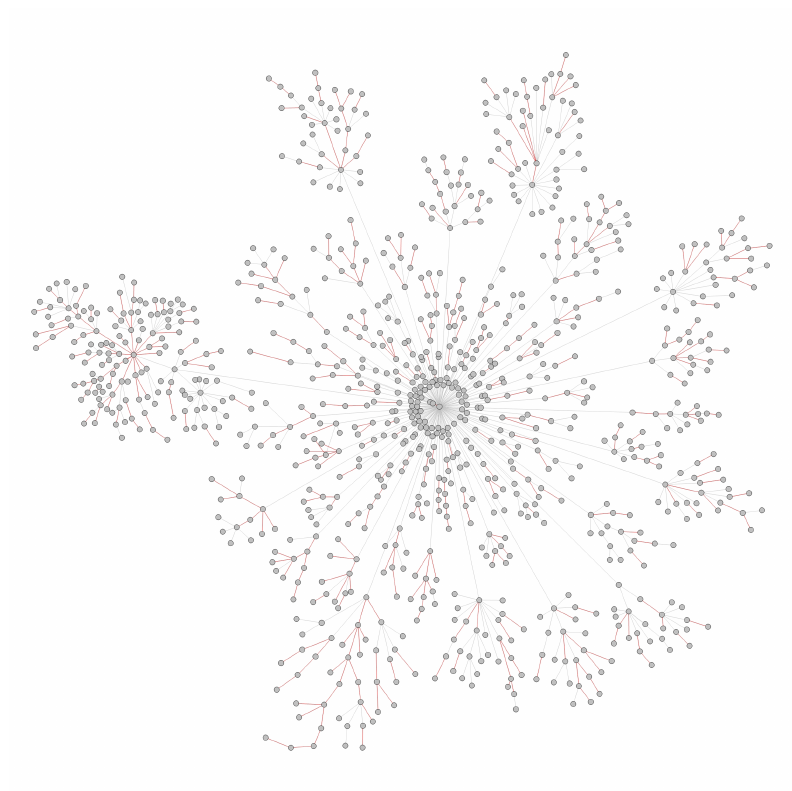
Figure A2. Abnormal edges in Canada transmission network.